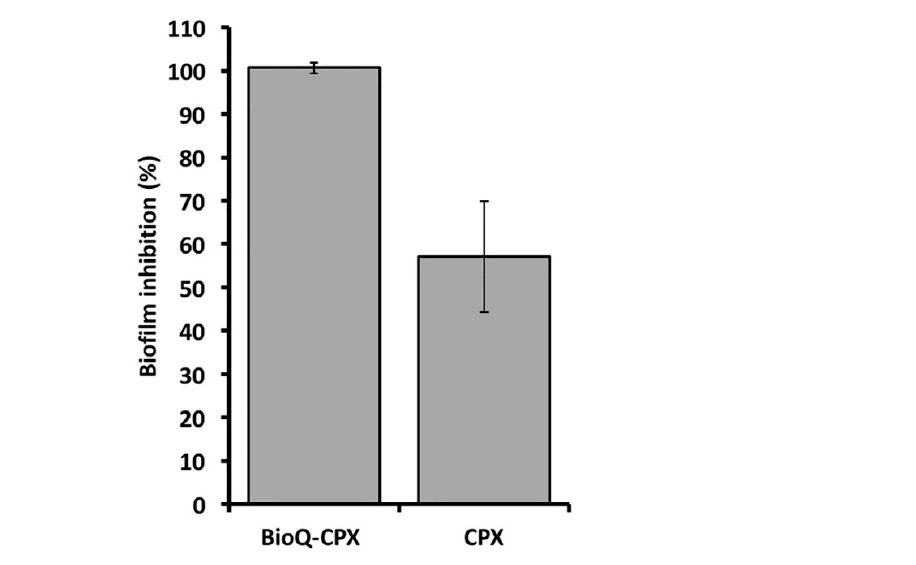
Figure 13. Antimicrobial activity of BioQ-CPX and CPX (as a reference) supplied as disks (5 mg) against S. aureus cells growing as a biofilm ( n = 3 ± SD). Significant differences between BioQ-CPX and CPX groups ( p < 0.05).